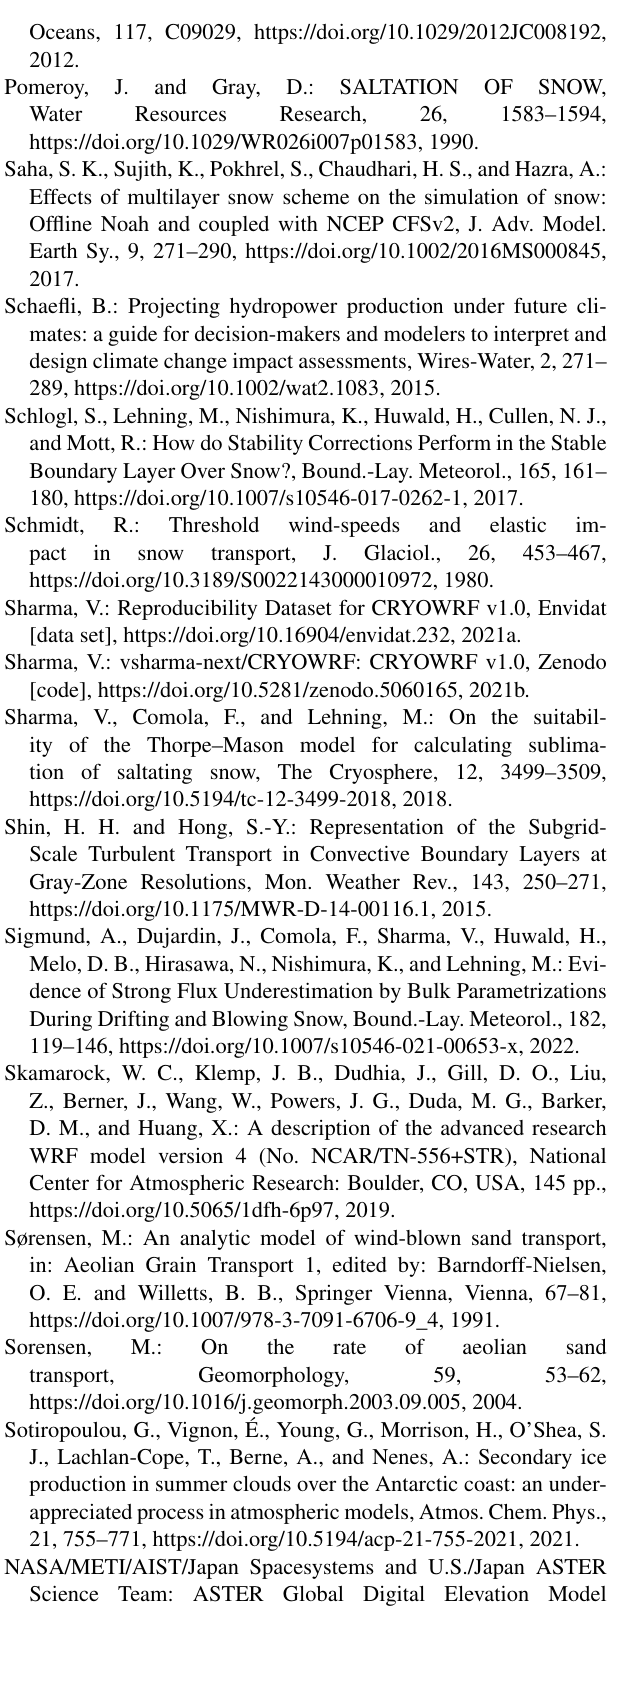
Tabler, R. D.: Controlling blowing and drifting snow with